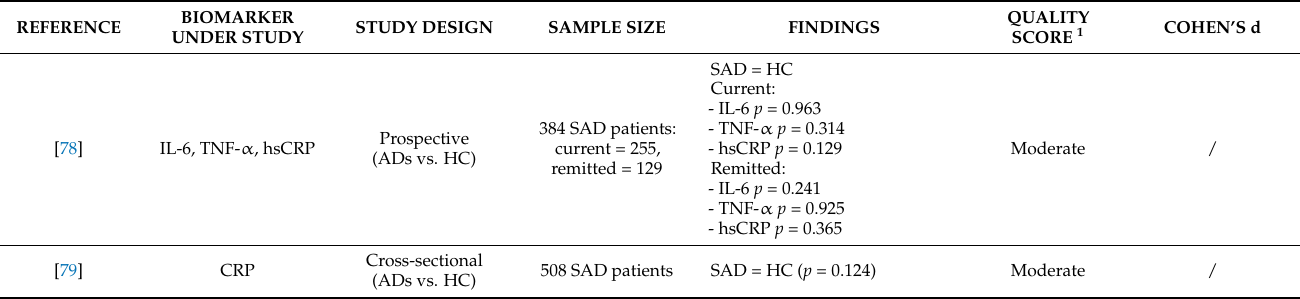
Table 3. Summary of findings regarding immunological biomarkers of